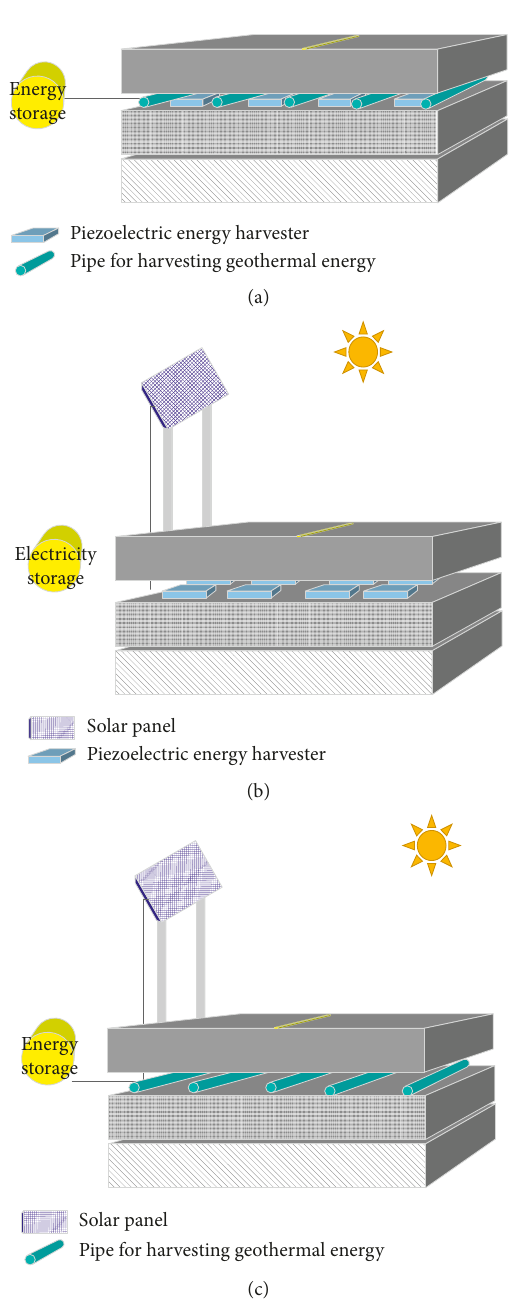
Figure 8: Hybrid energy harvesting systems: (a) hybrid piezo- electric-thermoelectric energy harvester, (b) solar-piezoelectric composite energy harvester, and (c) solar-geothermal energy harvester (based on